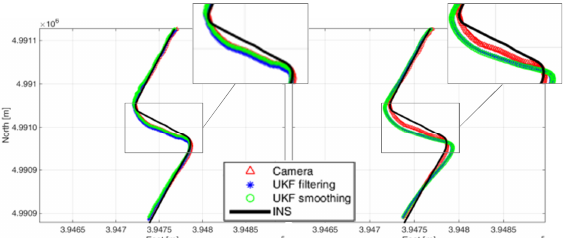
Figure 8. On the left: UKF augmented trajectory with 4 states; on the right: UKF not-augmented trajectories with 4 states In Table 3 are shown the same results of Table 1, but related to the motion model with 5 states (